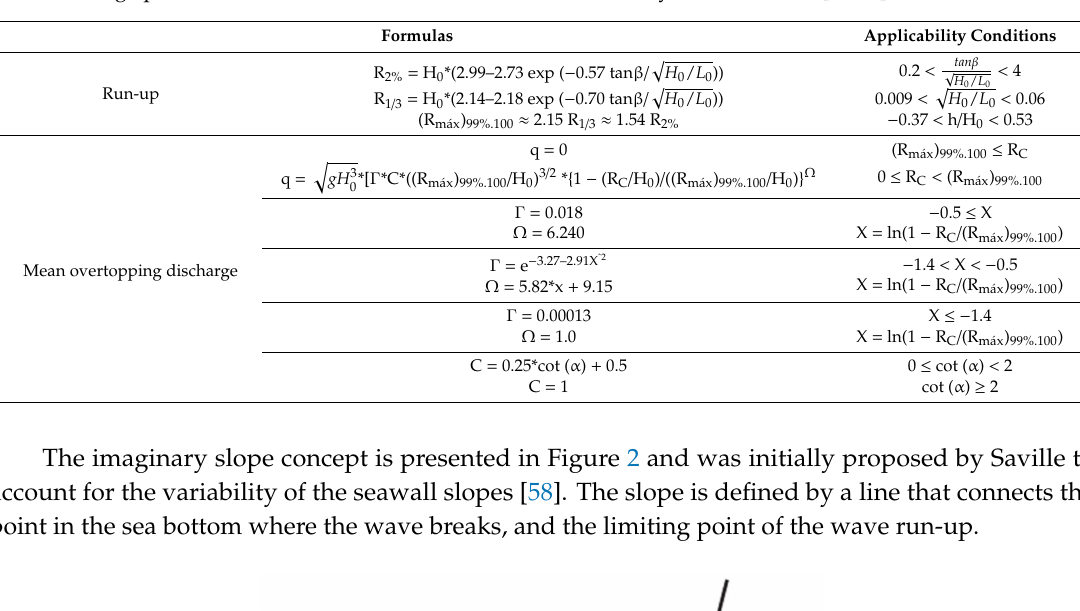
Table 1. Mase formulas and applicability conditions for the wave run-up and mean overtopping discharge prediction on seawalls constructed on land or in very shallow water [23,57].